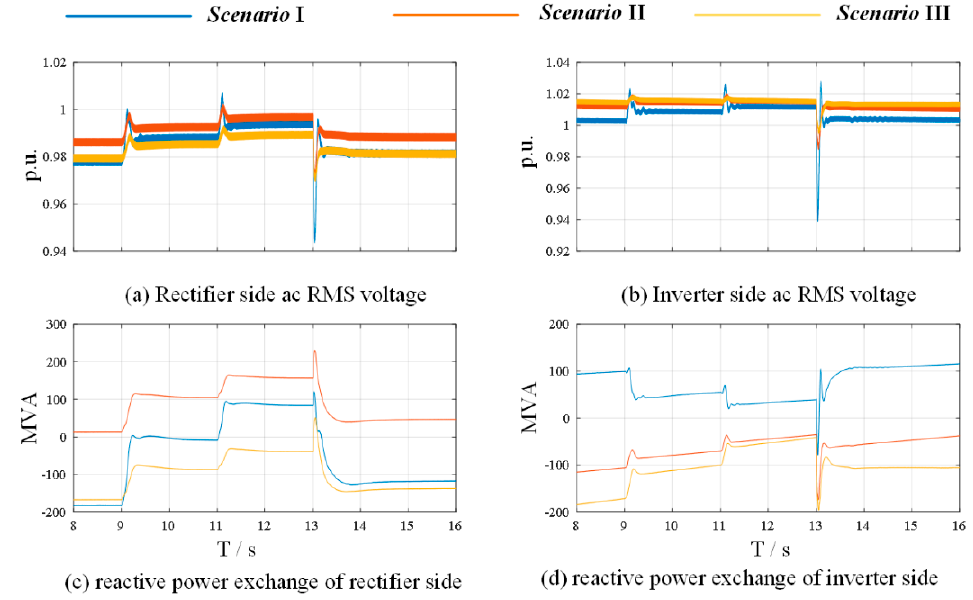
Figure 17. Proposed strategy with different short circuit ratio (SCR).